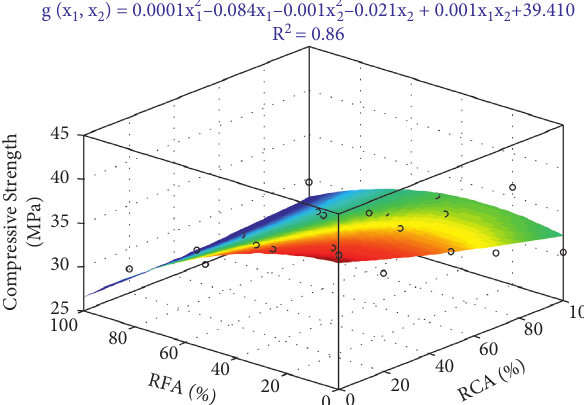
Figure 12: Compressive strength RCA–RFA RSM response.